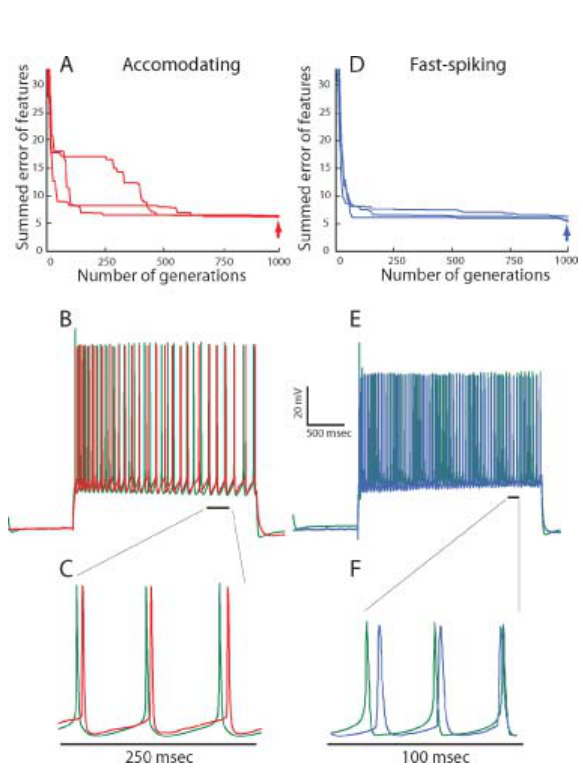
Figure 3. Fitting of model to experimental traces using multi-objective optimization procedure . (A) Convergence of summed errors for the accom- modatingbehaviorwithgeneration.Errorsforthesixobjectives(inSDunits)are weighted equally and summed to a single error value. In each generation, 300 sets of parameter values (values for maximal ion conductance) are evaluated simultaneously. The error value for the set of parameters that yield the mini- mal error is plotted. The three lines show the same fitting procedure repeated using different random initial conditions. (B) Comparison between one of the experimental responses (red) of the accommodating neuron shown in Figure 1A , to a 225 pA, 2seconds depolarizing current pulse and the model response (green trace) to the same input, using the best set of ion channel conductances obtainedatthe1000thgeneration(pointdenotedbyredarrowin A ).Thevalues of the channel conductances (in mS/cm 2 ) obtained in this fit are: Na t =359; Na p =0.00033; K fast =423; K slow =242; I A =99; Kv3.1=218; Ca=0.00667; SK=32.8; I h =10; I m =0; Leak soma =0.00737; Leak dendrite =0.001. (C) Zoom into the region marked by a black line in B . (D) Convergence of summed errors for the fast-spiking behavior for the six objectives with generation as in A . (E) Comparison between one of the experimental responses (blue) of the fast-spiking neuron shown in Figure 1B , to a 225pA, 2seconds depolarizing current pulse and the model response (green trace) to the same input, using the best set of ion channel conductances obtained at the 1000th generation (point denoted by blue arrow in D ). The values of the channel conductances (in mS/cm 2 ) for this fit are: Na t =172; Na p =0.1; K fast =0.5; K slow =199; I A =51; Kv 3.1=89; Ca=0.00153; SK=97; I h =4; I m =64; Leak soma =0.06; Leak dendrite =0.00163. ( F ) Zoom in to the region marked by a black line in E